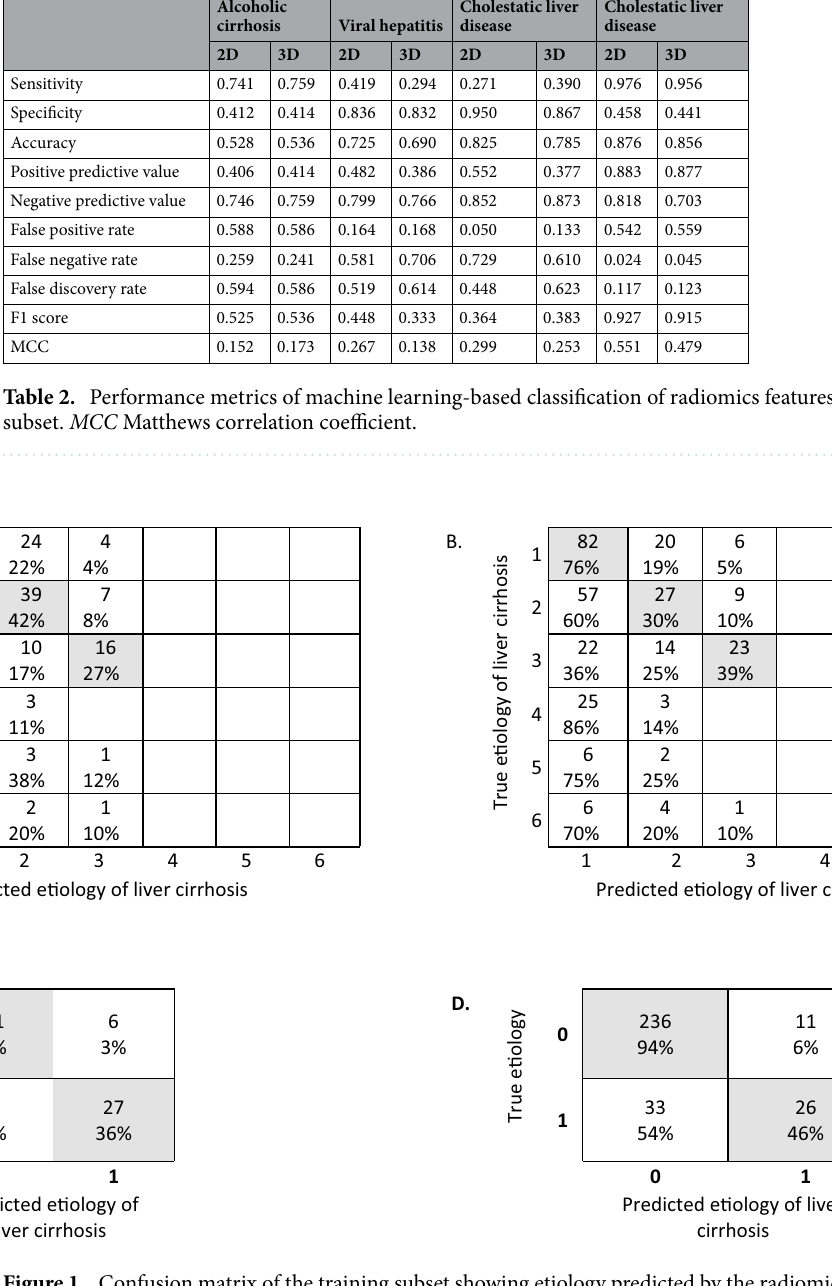
Figure 1. Confusion matrix of the training subset showing etiology predicted by the radiomics model in comparison to the diagnostically established etiology of liver cirrhosis. The shaded cells indicate correct predictions by the radiomics model. A and B are confusion matrices for all groups constructed using features extracted from 2-dimensional (2D) ( A ) and 3-dimensional (3D) ( B ) features. C and D are confusion matrices for noncholestatic (0) vs. cholestatic (1) liver cirrhosis in 2D ( C ) and 3D ( D )